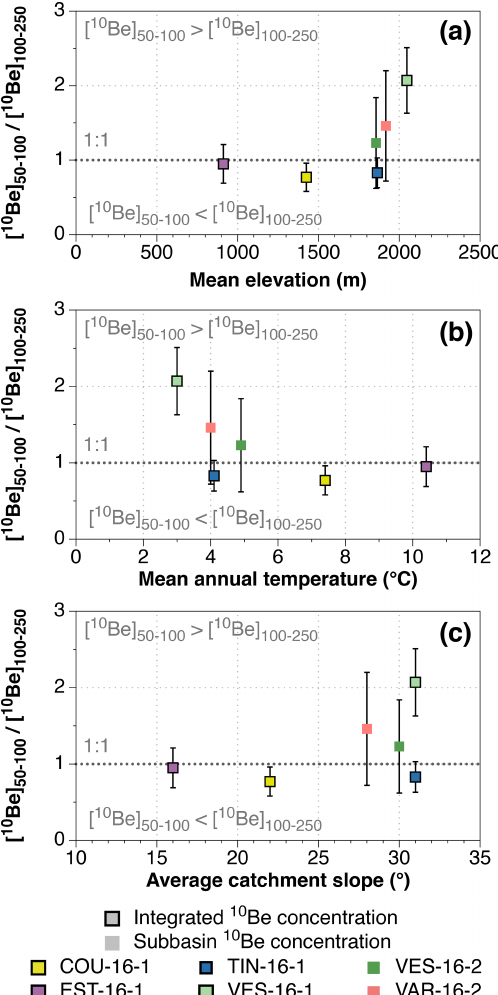
Figure 5. Differences in 10 Be concentrations of the 50–100 and 100–250µm size fractions as a function of (a) elevation, (b) mean annual temperature, and (c) average subbasin slope. Mean eleva- tion and temperature were calculated for quartz-bearing surfaces only using a 5m resolution DEM from the Institut National de l’Information Géographique et Forestière (http://professionnels.ign. fr/donnees, last access: 6 December 2019). Temperature data are from the WorldClim database (http://worldclim.org/version2, last access: 6 December 2019; Fick and Hijmans, 2017). Subbasin con- centrations (Table 2) are used for VES-16-2 and VAR-16-2 to ex- clude their nested upstream subbasins (VES-16-1 and COU-16-1,